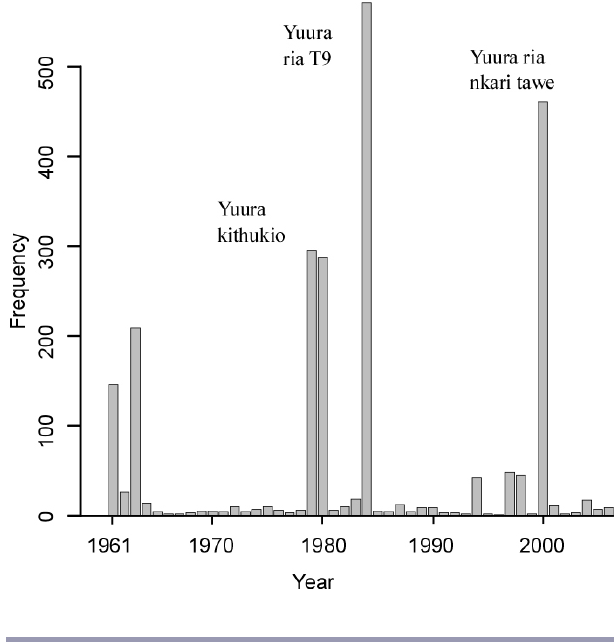
Fig. 2 . Frequency of drought reported by farmers (1961-2006). Names reported on the figure are those used in Meru drought nomenclature (see Table